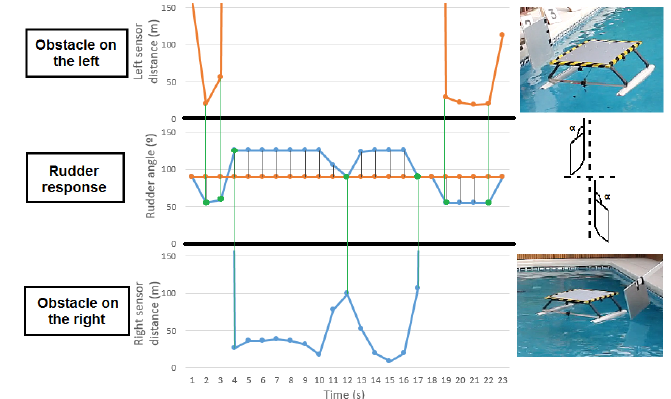
Figure 15. The upper plot shows the measured distance read by the left side sensor while the lower plot the measurements of the right-side sensor. In the central plot, the rudder response was represented as the rudder angle vs. time. Variations in the rudder angle are produced by the vessel’s response to